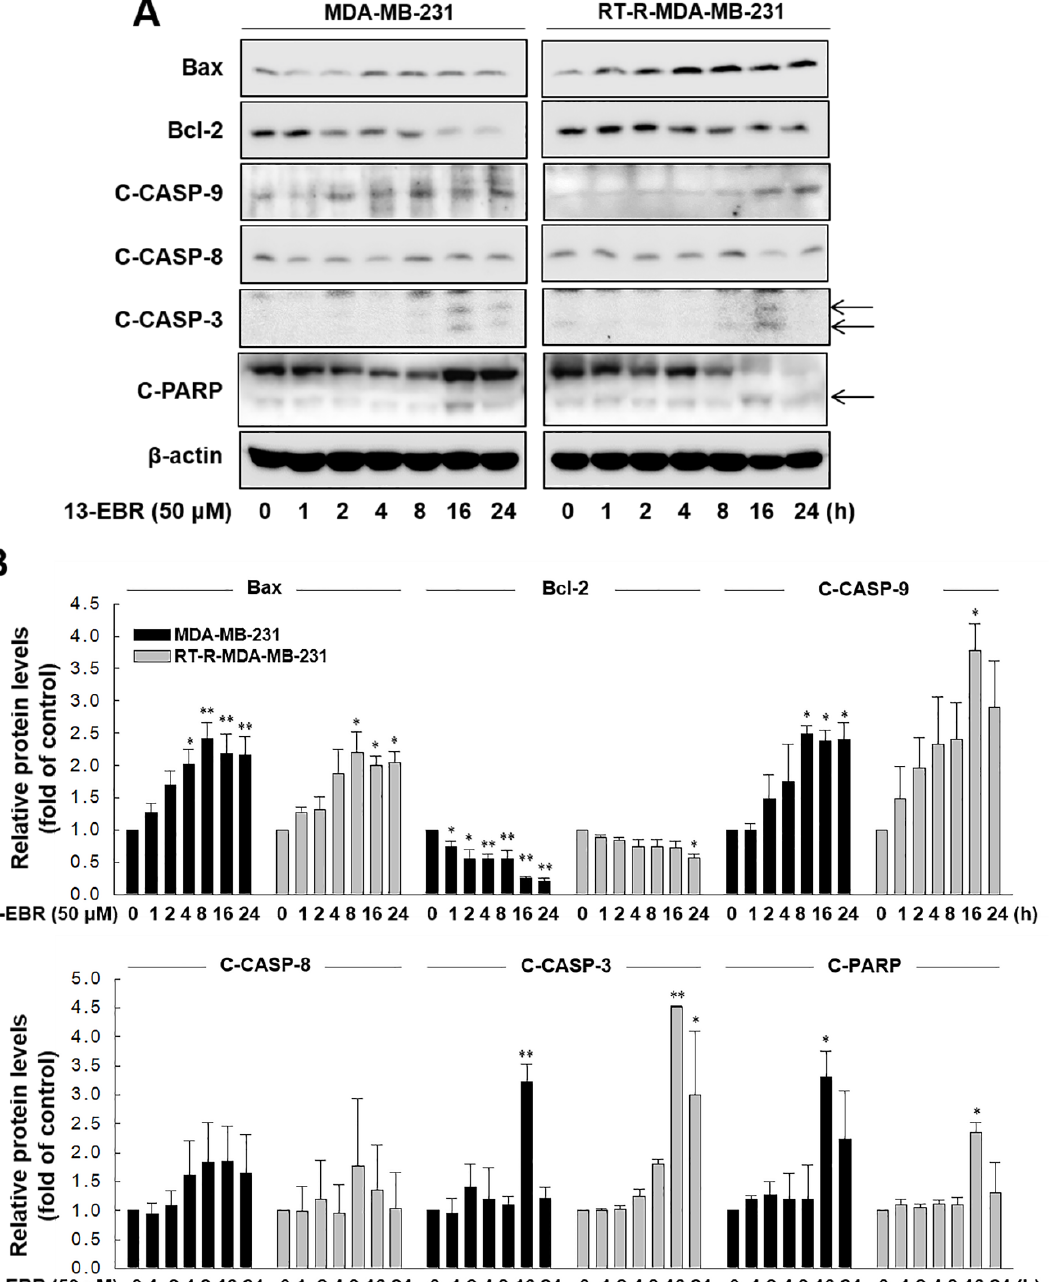
Figure 4. 13-EBR-mediated induction of apoptosis through the intrinsic pathway. ( A , B ) Both cell lines were stimulated with 50 µ M 13-EBR for the indicated times, and total proteins were extracted. The Bax, Bcl-2, cleaved caspase-9 (C-CASP-9), -8 (C-CASP-8), -3 (C-CASP-3), cleaved poly(ADP ribose) polymerase (C-PARP), and β -actin protein levels were analyzed in cell lysates by Western blotting ( A ), as described in Section 4, and were quantified ( B ). The values represent the mean ± SEM of three independent experiments; ** p < 0.01, * p < 0.05 compared to the control of each cell line.